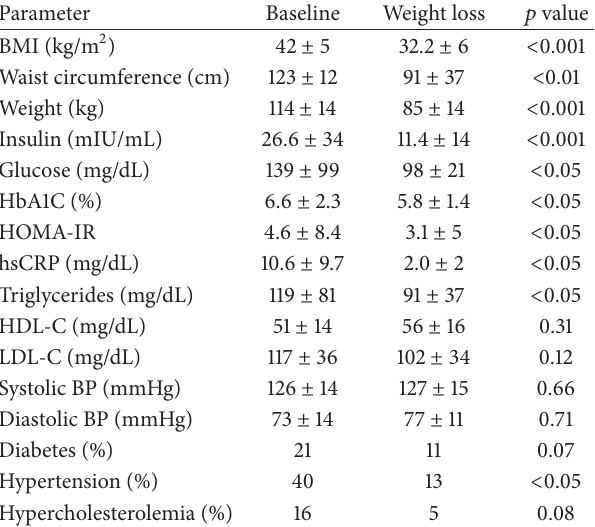
Table 1: Clinical